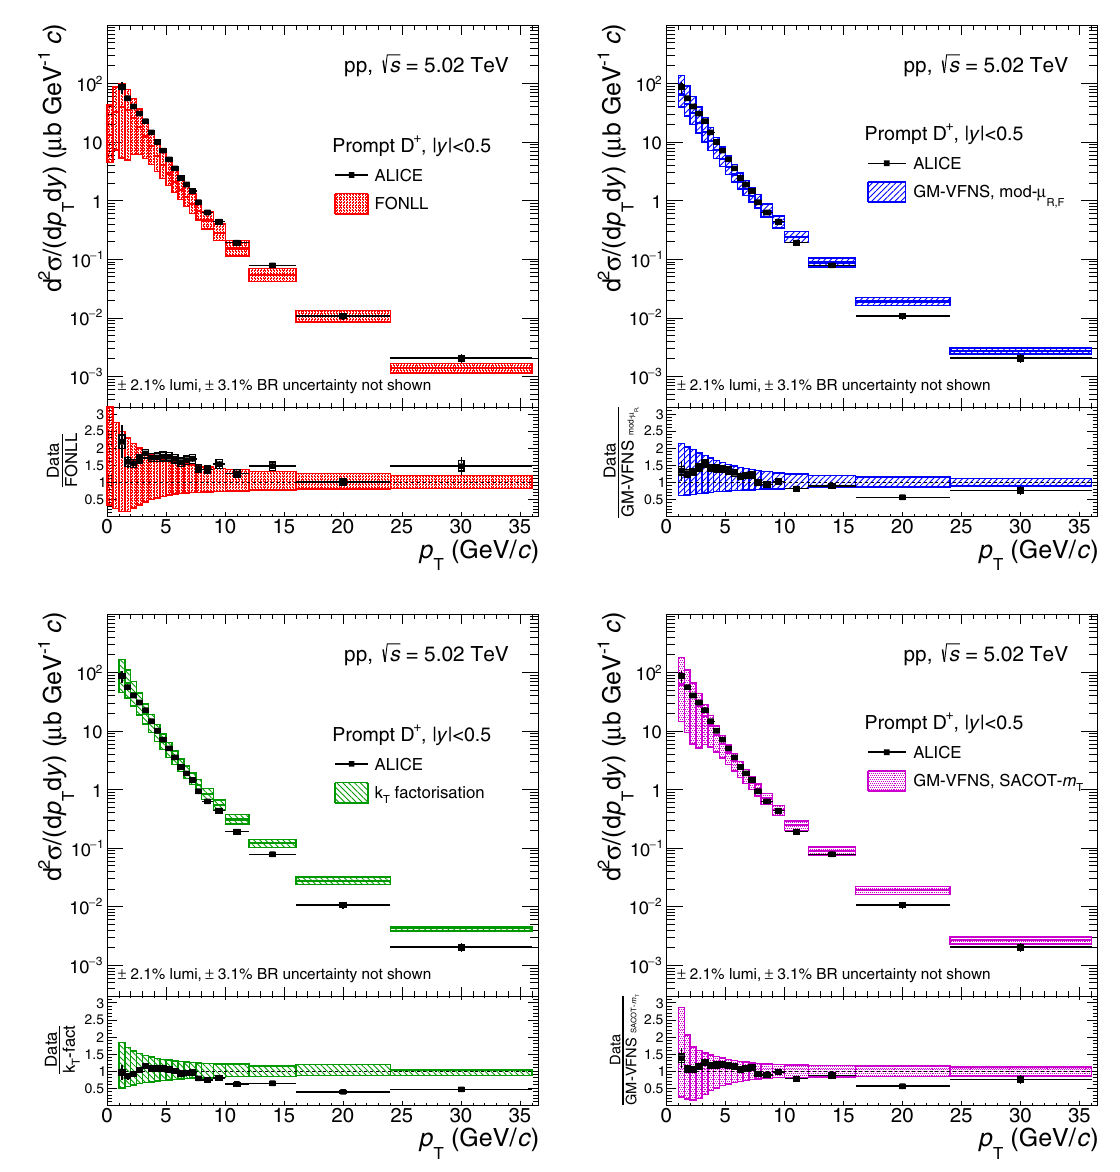
The ratios of the data to the theoretical predictions are shown in the lower part of each panel √ s = tainties with the ratios measured in pp collisions at 7 TeV [27]. 1 To study the evolution of prompt D-meson production with the centre-of-mass energy of the collision, the ratios √ s = of the production cross sections in pp collisions at √ s = 5 . 02 TeV were computed for D 0 , D + , 7 TeV [27] and √ 1 The cross section for D 0 and D + mesons in pp collisions at s = 7 TeV were updated with respect to Ref. [27] to account for the change of the world-average BR of D 0 → K − π + and D + → K − π + π + from (3 . 93% ± 0 . 04)to(3 . 89% ± 0 . 04),andfrom(9 . 46% ± 0 . 24)to(8 . 98% ± 0 . 28),